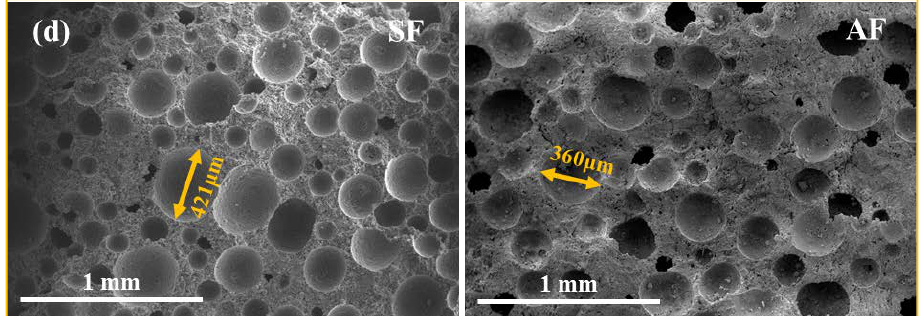
Figure 6. SEM of internal pores of FMLSB: ( a ) 437.5 kg/m 3 , ( b ) 670 kg/m 3 , ( c ) 902.5 kg/m 3 , ( d ) 1170 kg/m 3 .